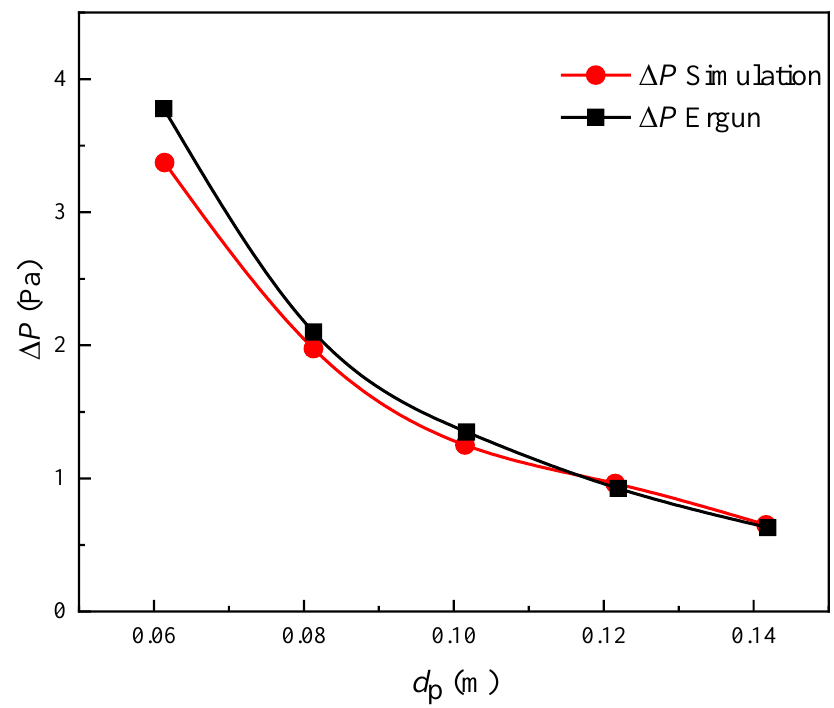
Figure 6. Comparison of pressure drop for the condition of different particle diameters from simu- lations and the Ergun equation. Table 3 below provides the values of pressure drop calculated by the Ergun equation and simulated pressure drop for different particle sizes. Combining Figure 6 and Table 3, an agreement can be achieved using CFD-DEM